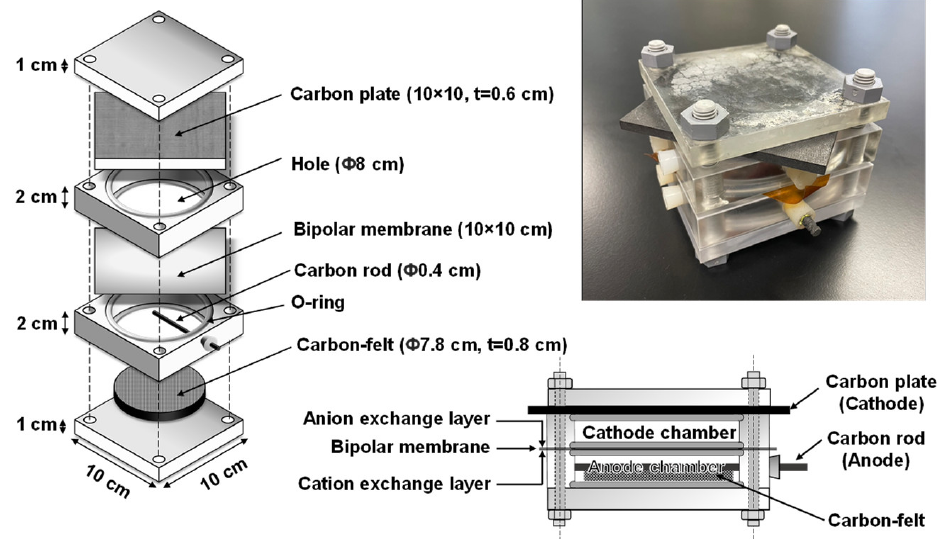
Figure 1. Assembly and cross-section of bMFC. The vessel parts were made of polycarbonate. The anode chamber’s carbon rod was connected to carbon felt, and 0.3 g iron (III) hydroxide was applied to a carbon plate.